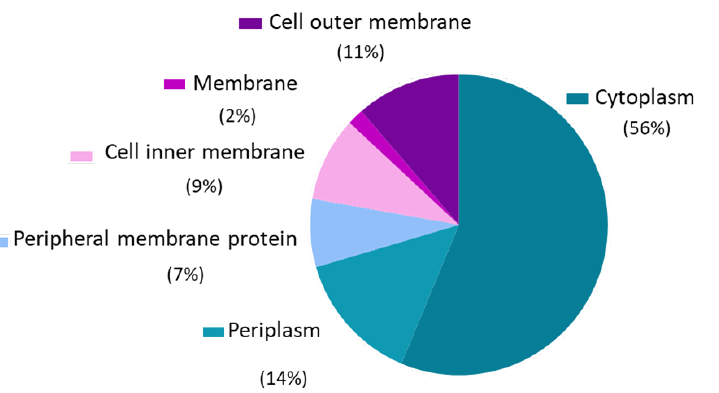
Figure 1. Subcellular distribution of proteins identified by proteomics of outer membrane vesicles (OMVs) isolated from two clinical Enterotoxigenic Escherichia coli (ETEC) isolates.